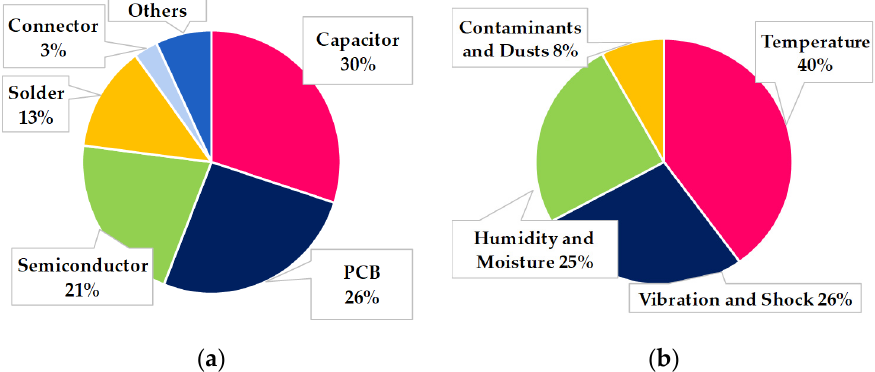
Figure 1. Failure distribution in power electronics systems: ( a ) Fault components in power converters; ( b ) Failure influence factors.